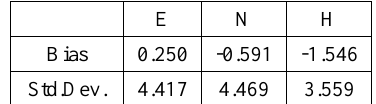
Table 6. The bias and the standard deviation of the differential DSM between the twin ZY-3 DSMs (unit: meter)